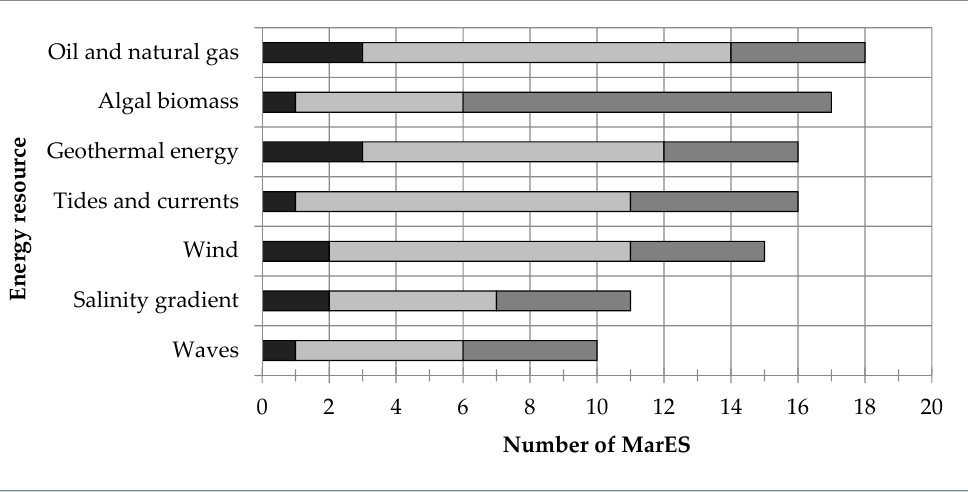
Figure 1. Overview of the number of marine ecosystem services (MarES) each energy field interacts with. The figure shows the energy fields that use offshore oil and natural gas, offshore wind, tides and ocean currents, waves, salinity gradients, algal biomass, and offshore geothermal energy. Additionally, a field’s dependence (black) and impact (light grey) on MarES as well as bidirectional interactions (dark grey) are indicated.